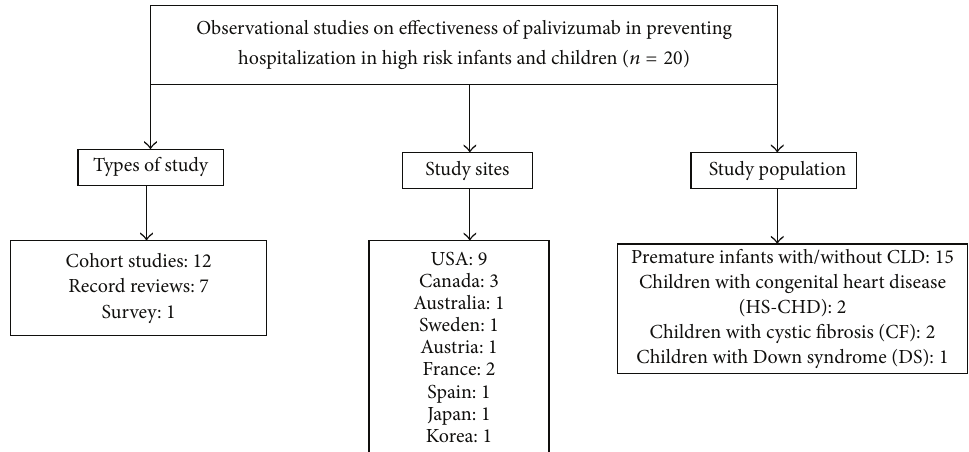
Figure2:CharacteristicsoftheselectedstudiesoneffectivenessofpalivizumabinreducingRSV-associatedhospitalizationinhighriskinfants and